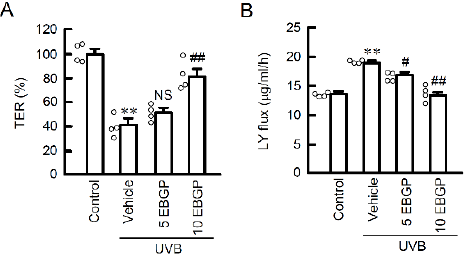
Figure 1. Effect of EBGP on TJ permeability against weak UVB irradiation. The cells were cultured on transwell plates and incubated in the absence (vehicle) and presence of 5 or 10 μg/mL EBGP for 30 min, followed by exposure to 5 mJ/cm 2 UVB for 6 h. ( A ) TER was measured by volt-ohm meter. The data were presented as a percentage of control. ( B ) Paracellular permeability of LY was measured using a fluorescence spectrometry. n = 4. ** p < 0.01 vs. control. # p < 0.05, ## p < 0.01 and NS p > 0.05 vs.